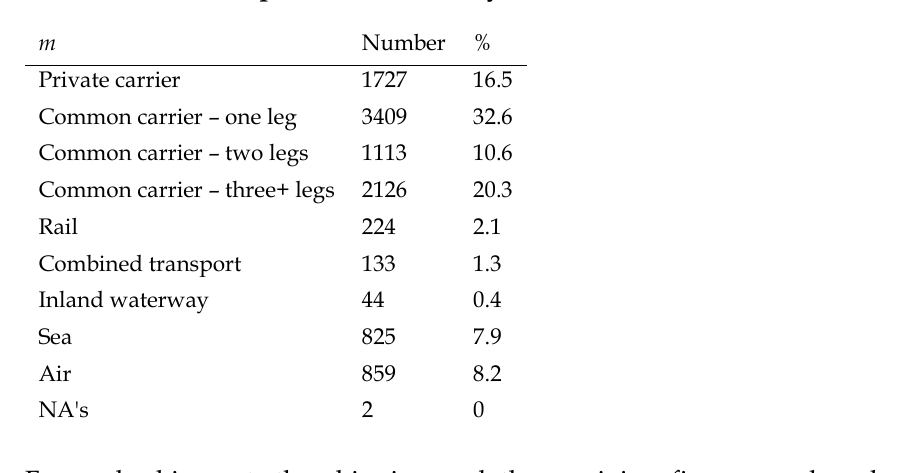
Table 1. Main transport mode summary